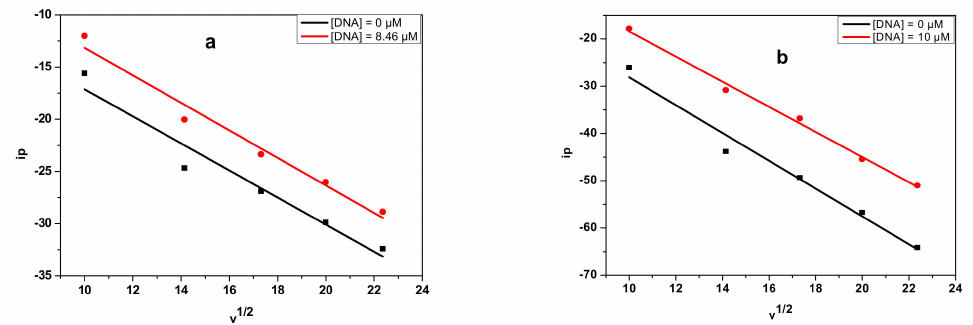
√ v versus i p used to calculate the coefficient diffusion of the free and E 2 - and Figure 9. Plots of E 3 -bound DNA: ( a ) E 2 ; ( b ) E 3 .